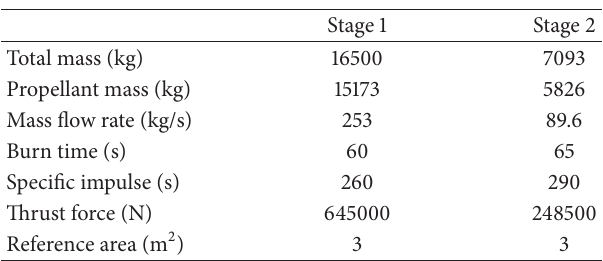
Table 1: Launch vehicle properties.